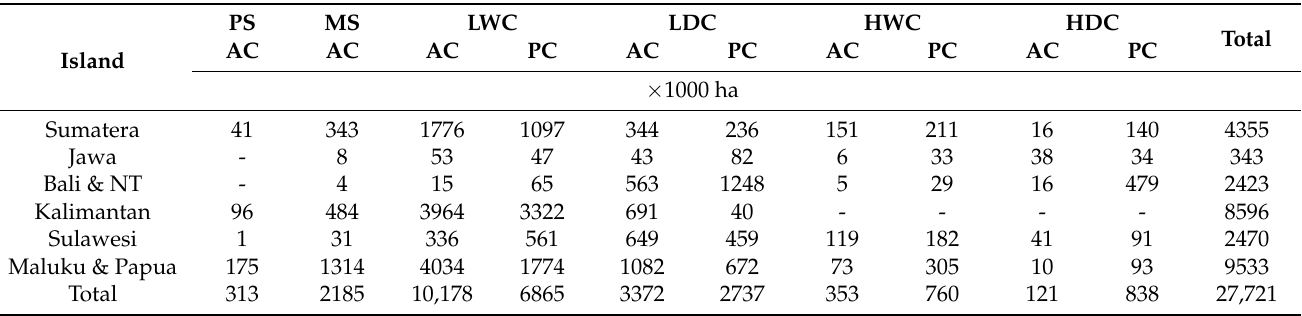
Table 5. The suitability of AL for annual and perennial crop development based on their agroecosys- tems in